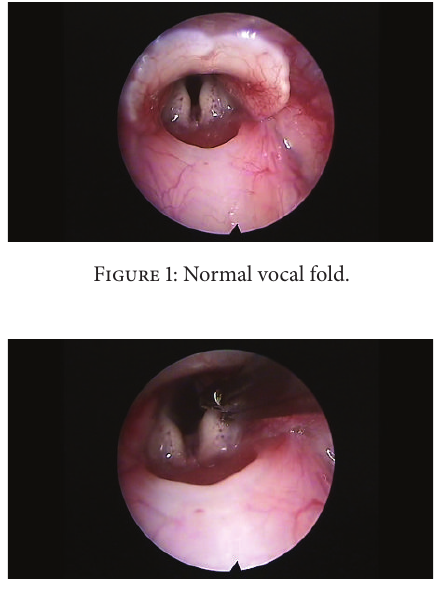
Figure 2: Creation of a trauma using cold